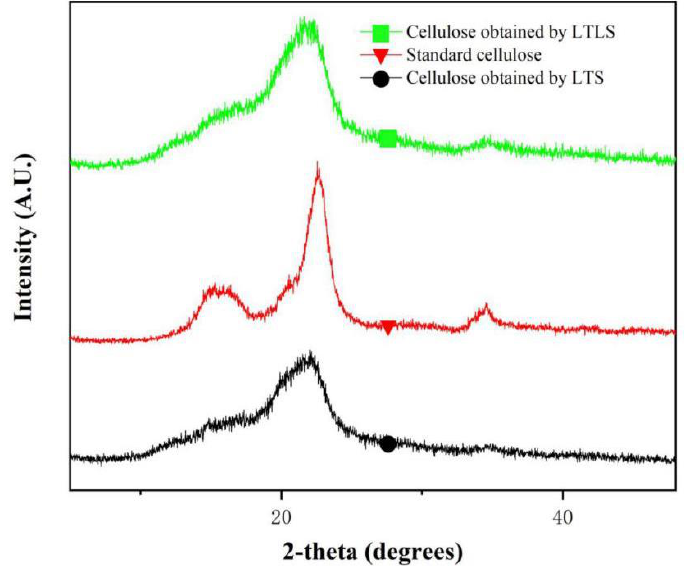
Figure 3. XRD spectrum of LTS and LTLS products and standard cellulose (wavelength: 1.5418 A).